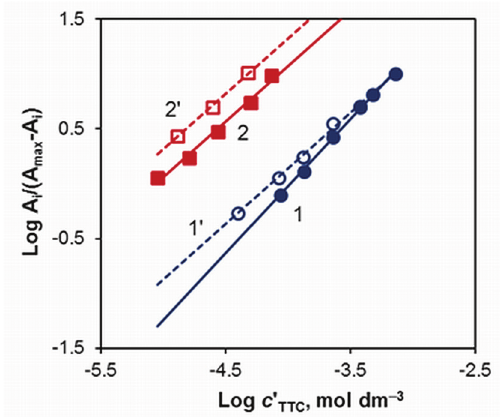
Figure 5: Determination of the TTC:vanadium molar ratios by the mobile equilibrium method; m=1. pH 5.5, c 4.0×10 −4 mol dm −3 , λ = 333 nm (1 and 2) or 630 nm (1’ and 2’). 1